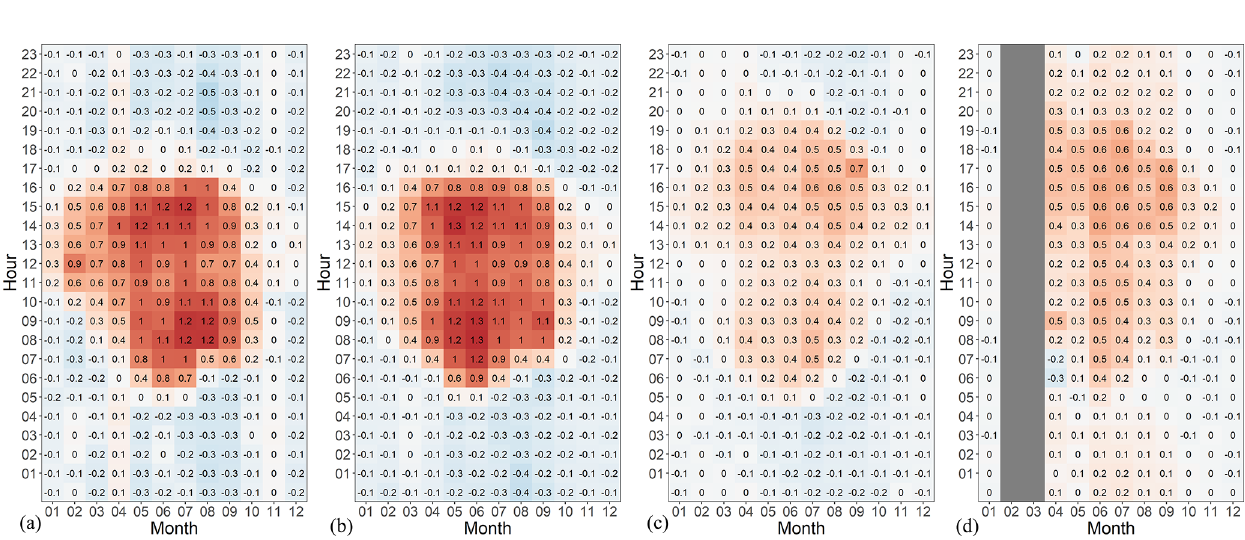
Figure 14. Same as Fig. 10 but for QC level 2.